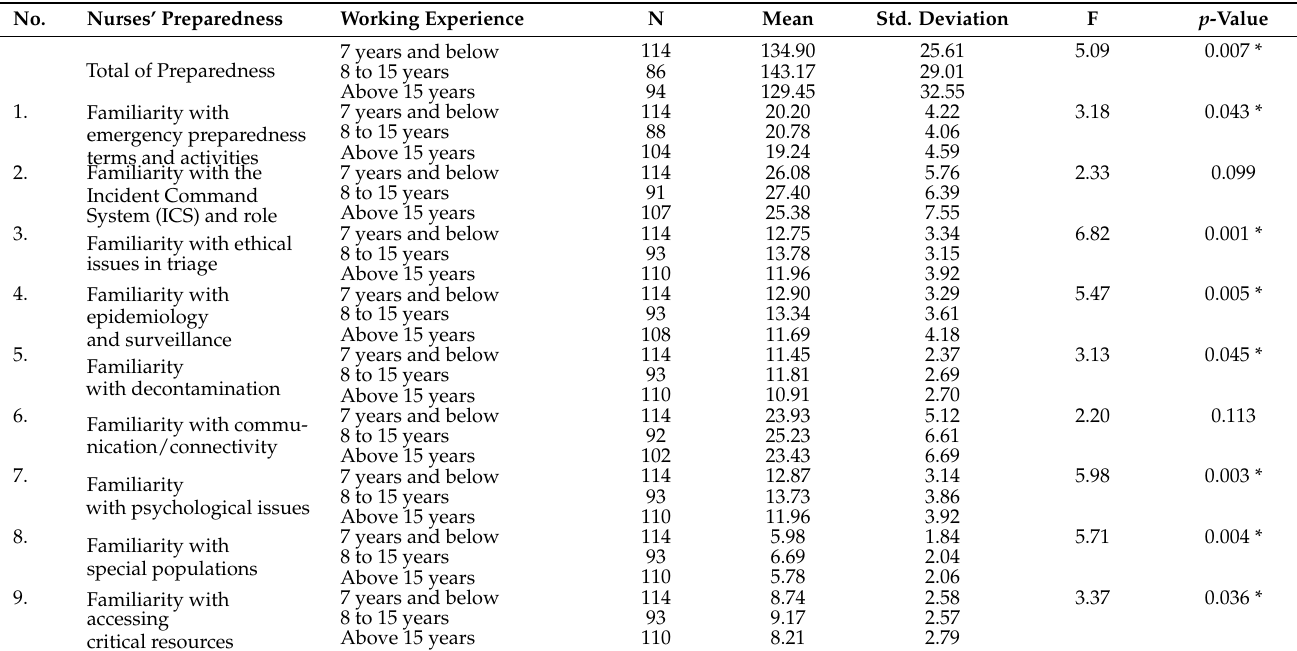
Table 4. Analysis of variance of the nurses’ preparedness in managing COVID-19 pandemic across three categories of working